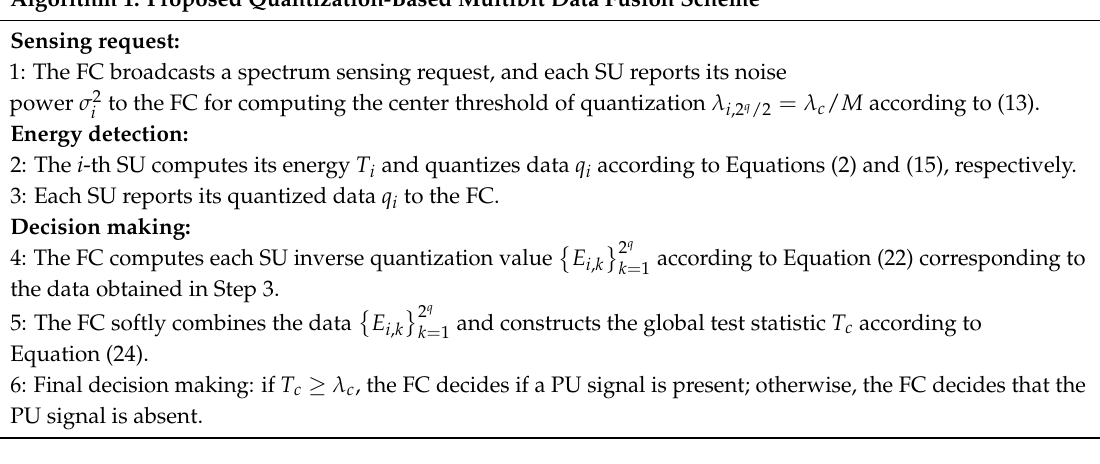
Algorithm 1. Proposed Quantization-Based Multibit Data Fusion